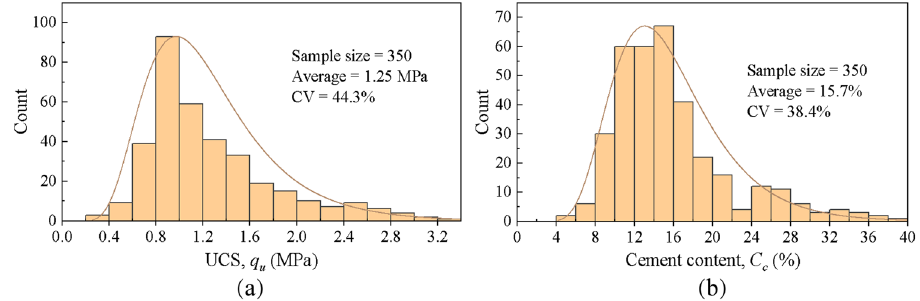
Figure 7. Histograms of UCS and cement content of core samples ( a ) UCS, ( b ) cement content.